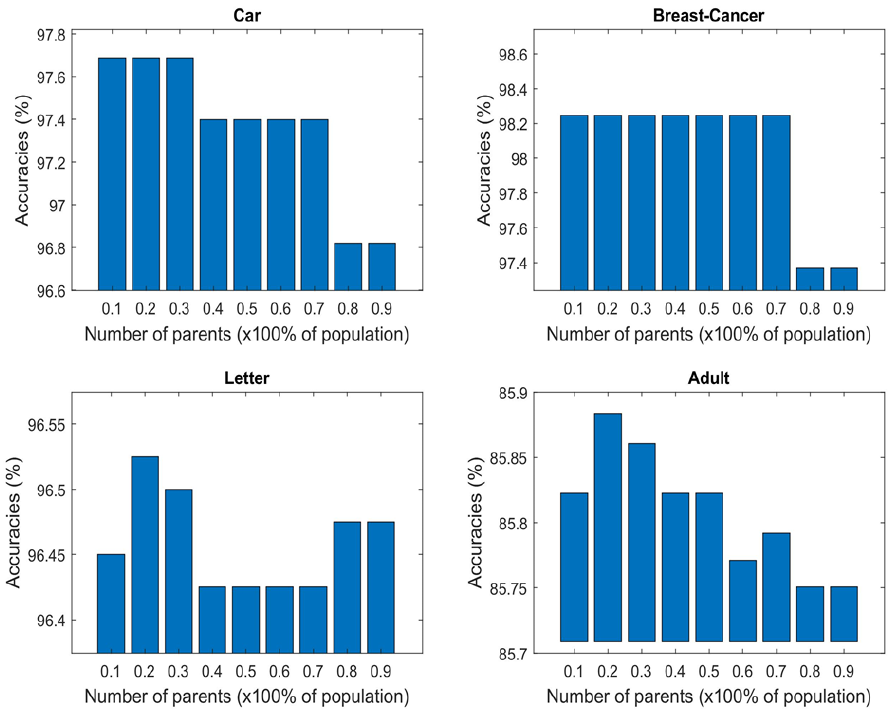
Figure 5. Comparison of accuracy of the UCI datasets under varying parent population